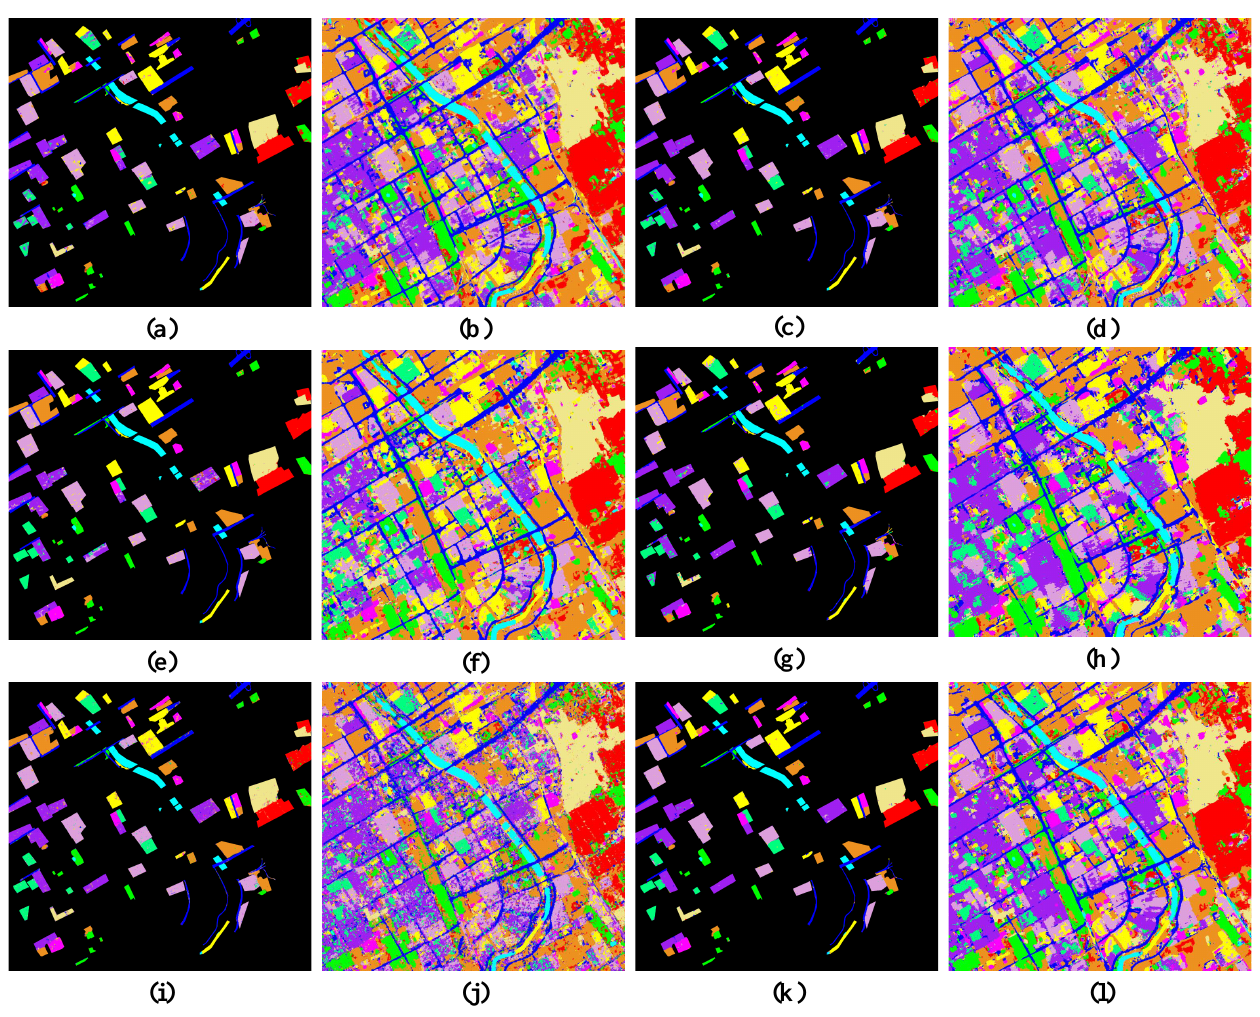
Figure 9. Classification maps of different methods on the Hohhot Level 1A Images(2001 × 2101), each method has two classification maps: one is image with ground truth, while the other is overall image. ( a , b ) Pixel-Centric+SE-Net(Res18). ( c , d ) ANTSS+SE-Net(Res18). ( e , f ) ACO-SS+DBAF-Net. ( g , h ) DMIL. ( i , j ) SML-CNN ( k , l )